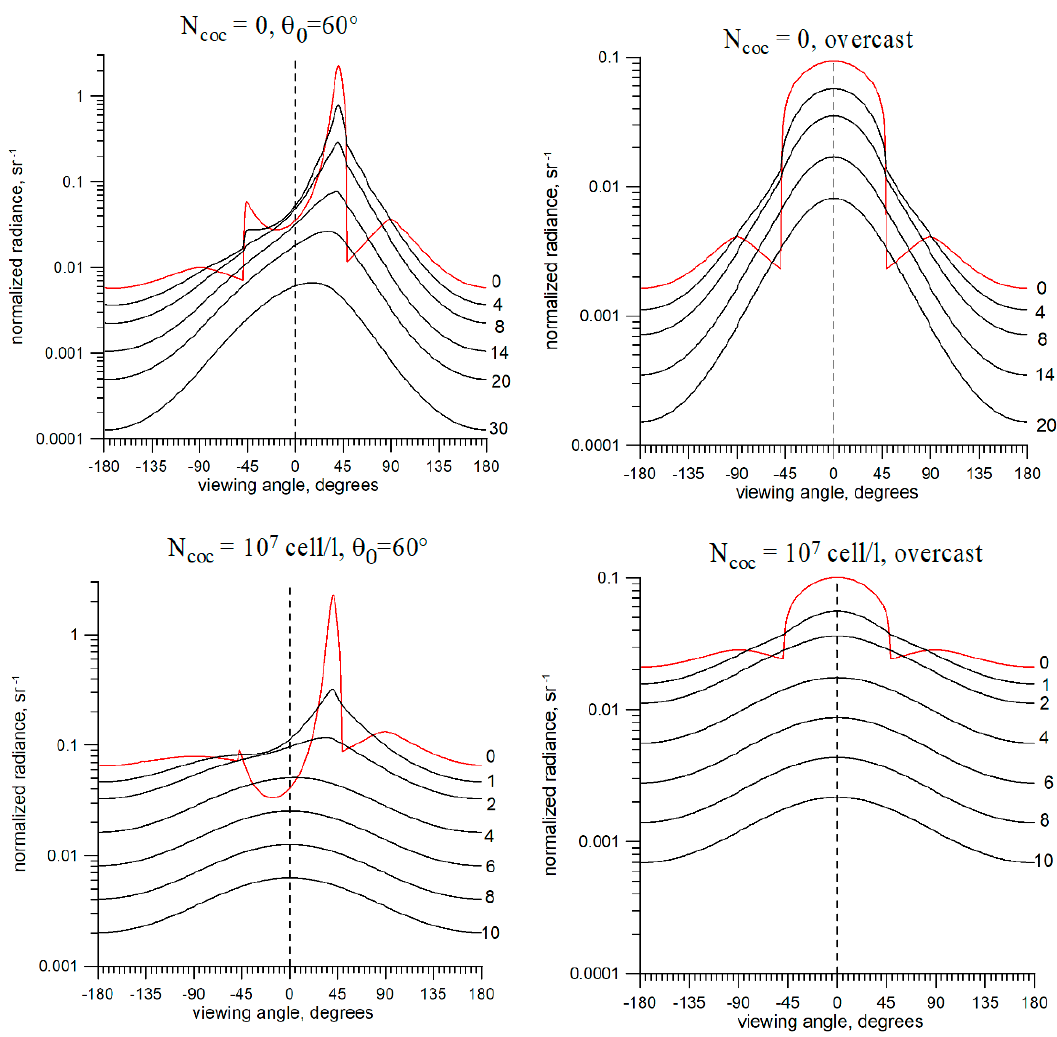
Figure 6. Black Sea. The angular radiance distributions for different observation conditions. On the left, the solar zenith viewing angle θ 0 = 60°, on the right, overcast condition. All others are the same as in Figure 4.